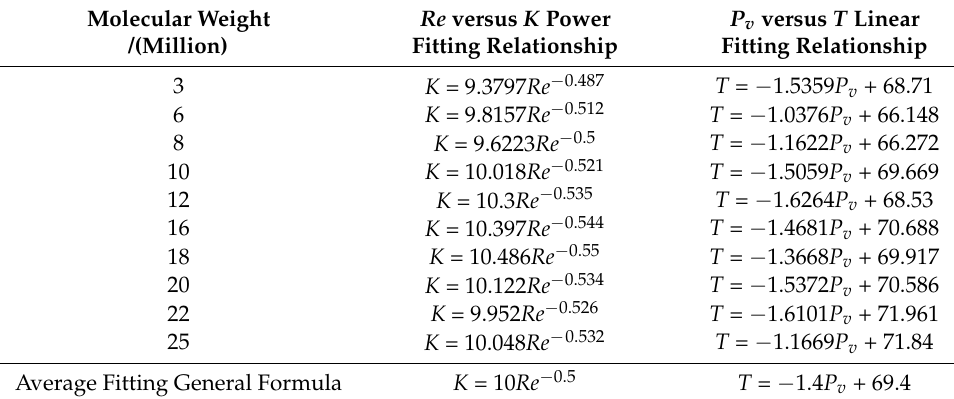
Table 11. Application formula fitting of stirring time